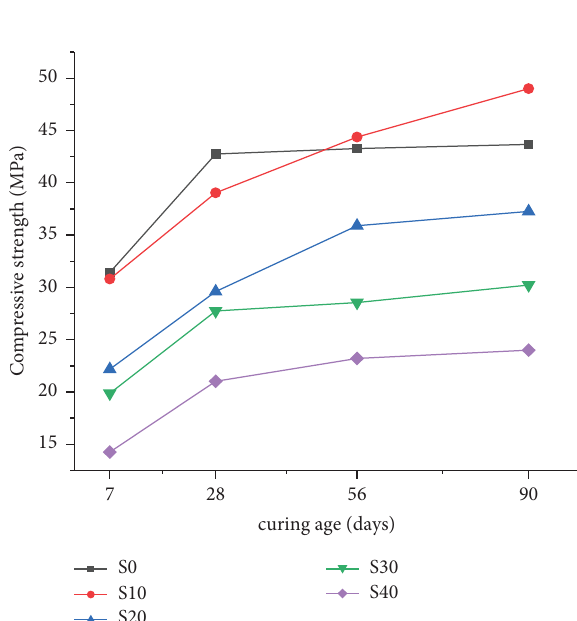
Figure 8: Compressive strength of concrete specimens versus time.